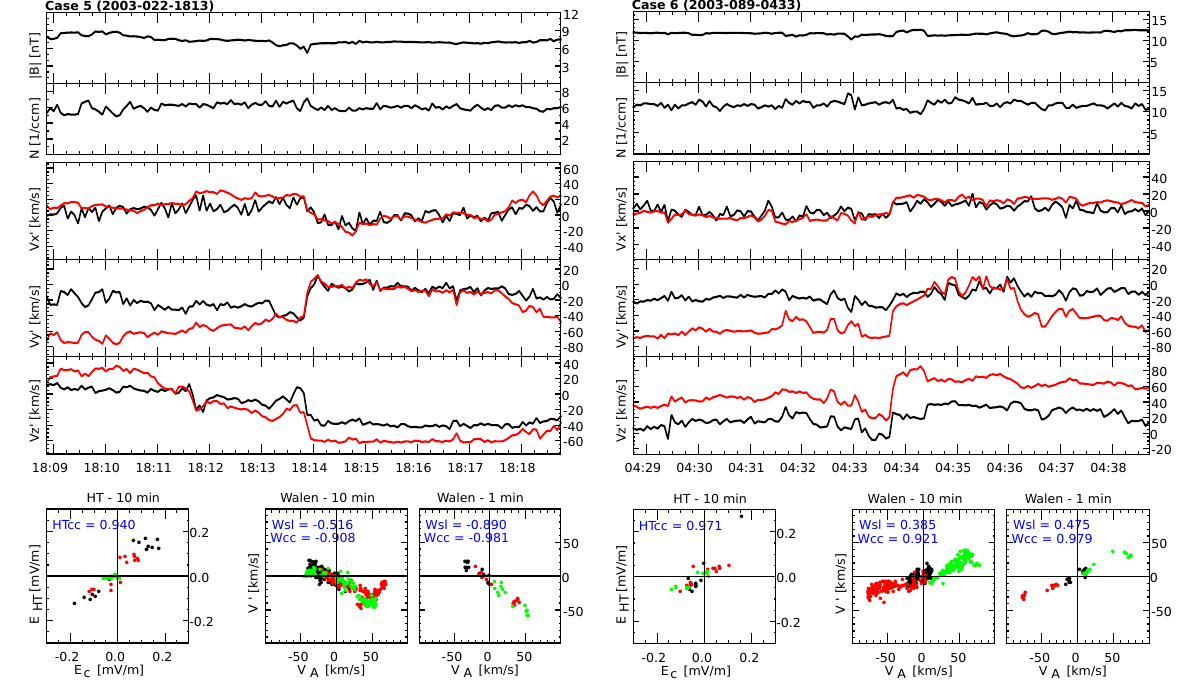
Fig. 3. Overview plots for DD crossings 5 and 6 from Table 1, in the same format as Fig. 2.